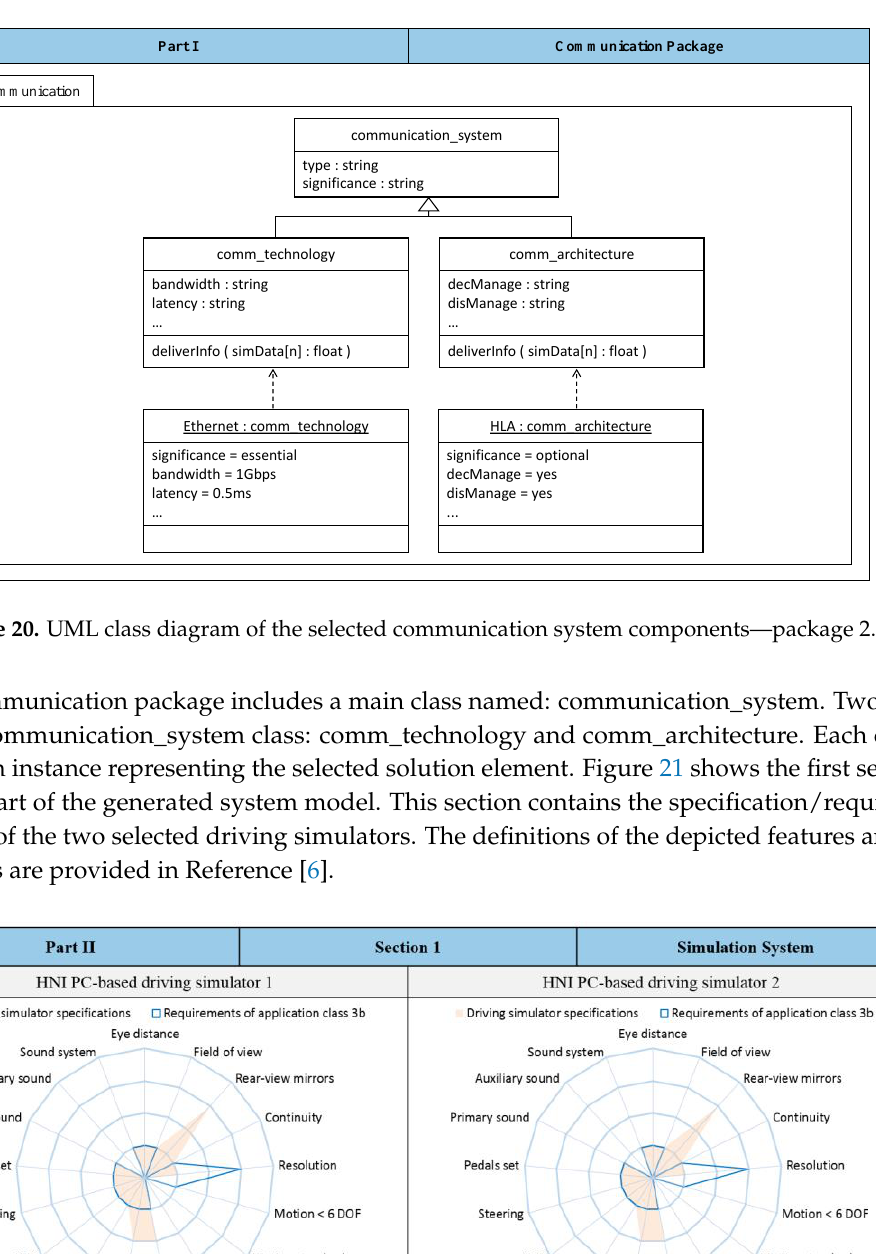
Figure 19. UML class diagram of the selected simulation system components—package 1.